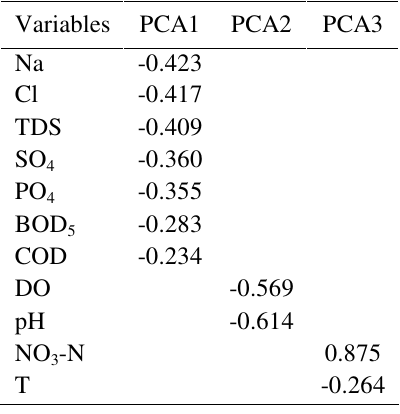
Table 3. Principal component analysis component